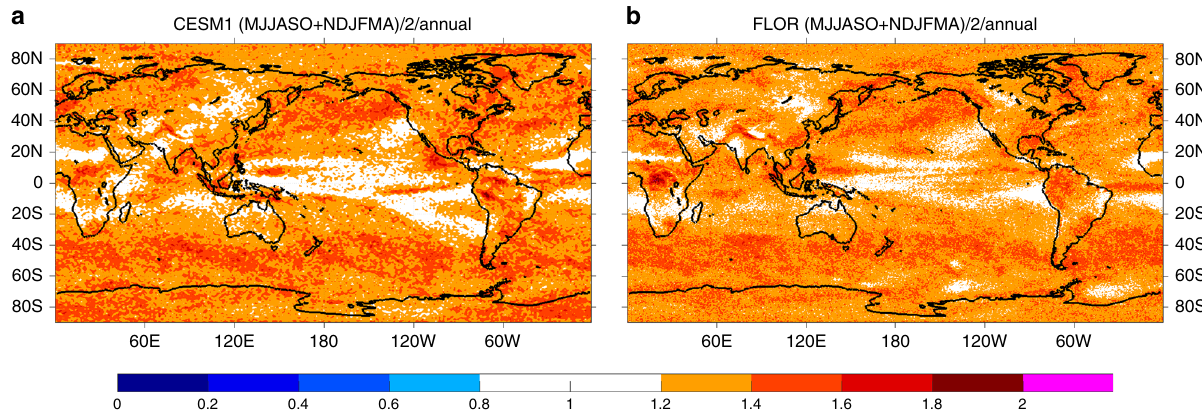
Fig. 4 Ratio of the average precipitation noise between NDJFMA and MJJASO to the annual precipitation noise. a CESM1 and b FLOR. The noise refers to the precipitation low-frequency internal variability and is estimated as the difference between the maximum and minimum (i.e., the most positive and negative) values of the 5000 samples constructed with the Monte Carlo approach from fully coupled control simulations. The annual noise is plotted in Fig. 3e, f while the NDJFMA and MJJASO noise is plotted in Supplementary Figures 6e, f and 7e, f,